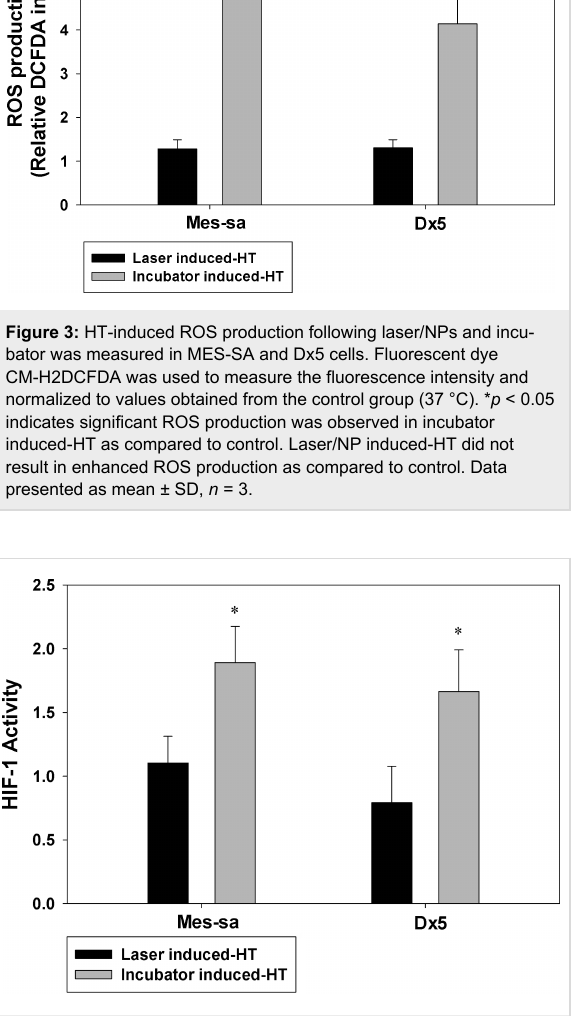
Figure 4: HT-induced HIF-1 expression after laser/NPs and incubator was measured in MES-SA and Dx5 cells. HIF-1 activity was assayed by using HIF-1 ELISA. All measured values were normalized to the mean value of the treatment at 37 °C. * p < 0.05 indicates significant HIF-1 expression was observed in incubator induced-HT as compared to control. Laser/NP induced-HT did not result in promoted HIF-1 expression compared to control. Data presented as mean ± SD, n = 3.